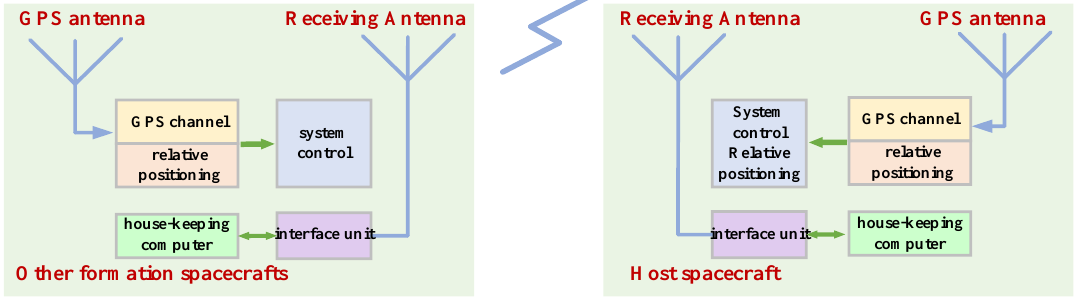
Figure 15. Principle diagram of the GPS relative measurement system.